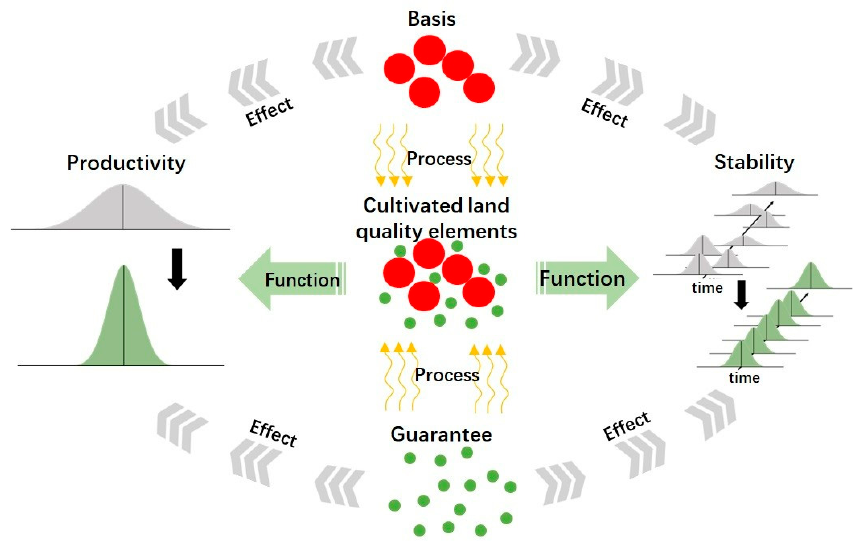
Figure 2. Factors of cultivated land quality and their correlation. The upper red circle represents the basic part of the cultivated land quality and the lower red circle represents the guarantee part of the cultivated land quality. The two are added together as the cultivated land quality elements. The function of cultivated land quality is reflected in productivity and stability. The left productivity graph is corresponding to the right stability graph, which means that the productivity of cultivated land is more and more concentrated and the stability is more and more strong with the change of time and the support of the foundation and guarantee part.